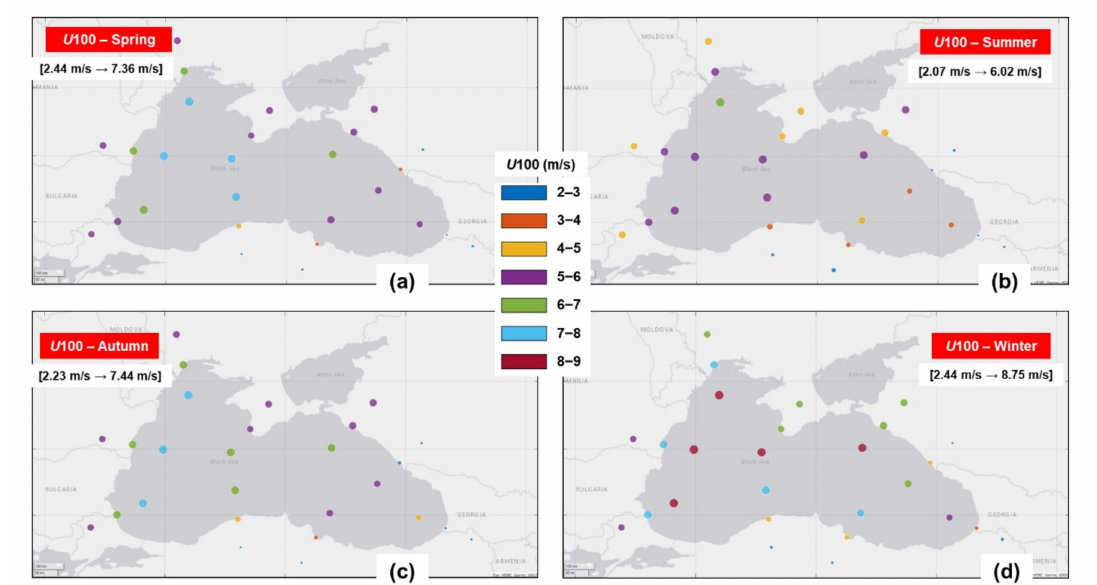
Figure 5. Seasonal distribution of the U 100 parameter (average values) associated with the 20-year time interval January 2002–December 2021, where: ( a ) spring; ( b ) summer; ( c ) autumn; ( d ) winter. The numbers from the square brackets indicate the minimum and maximum values related to each